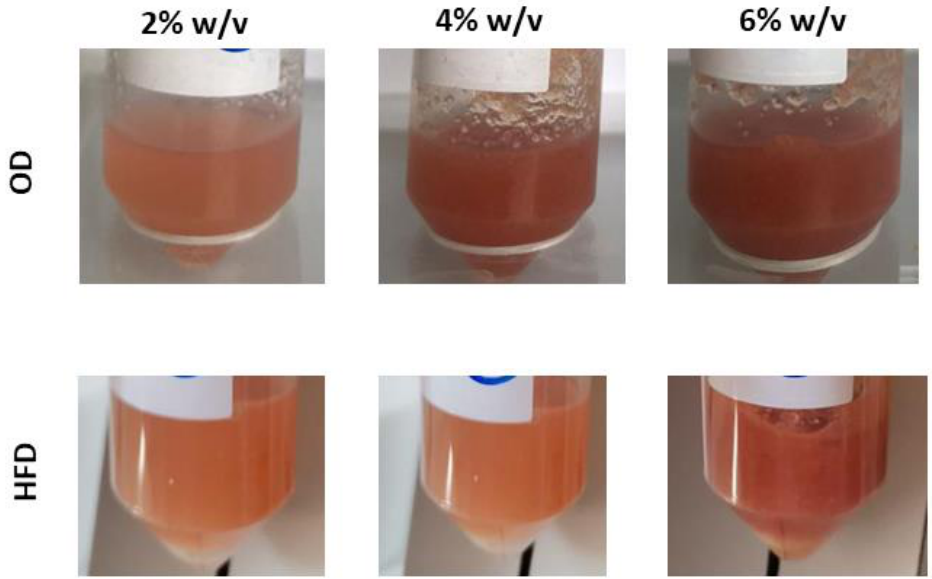
Figure 3. Hydrogels obtained with 2, 4, or 6% w/v of OD with the fraction PS 250–400 µ m ( upper row ) and HFD with the fraction PS > 400 µ m ( lower row ).